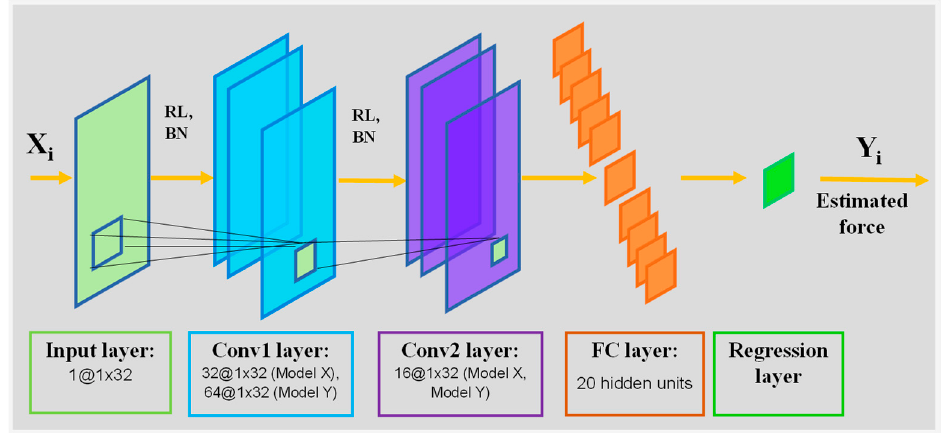
Figure 3. Proposed FMG-CNN architecture (Model X, Y).